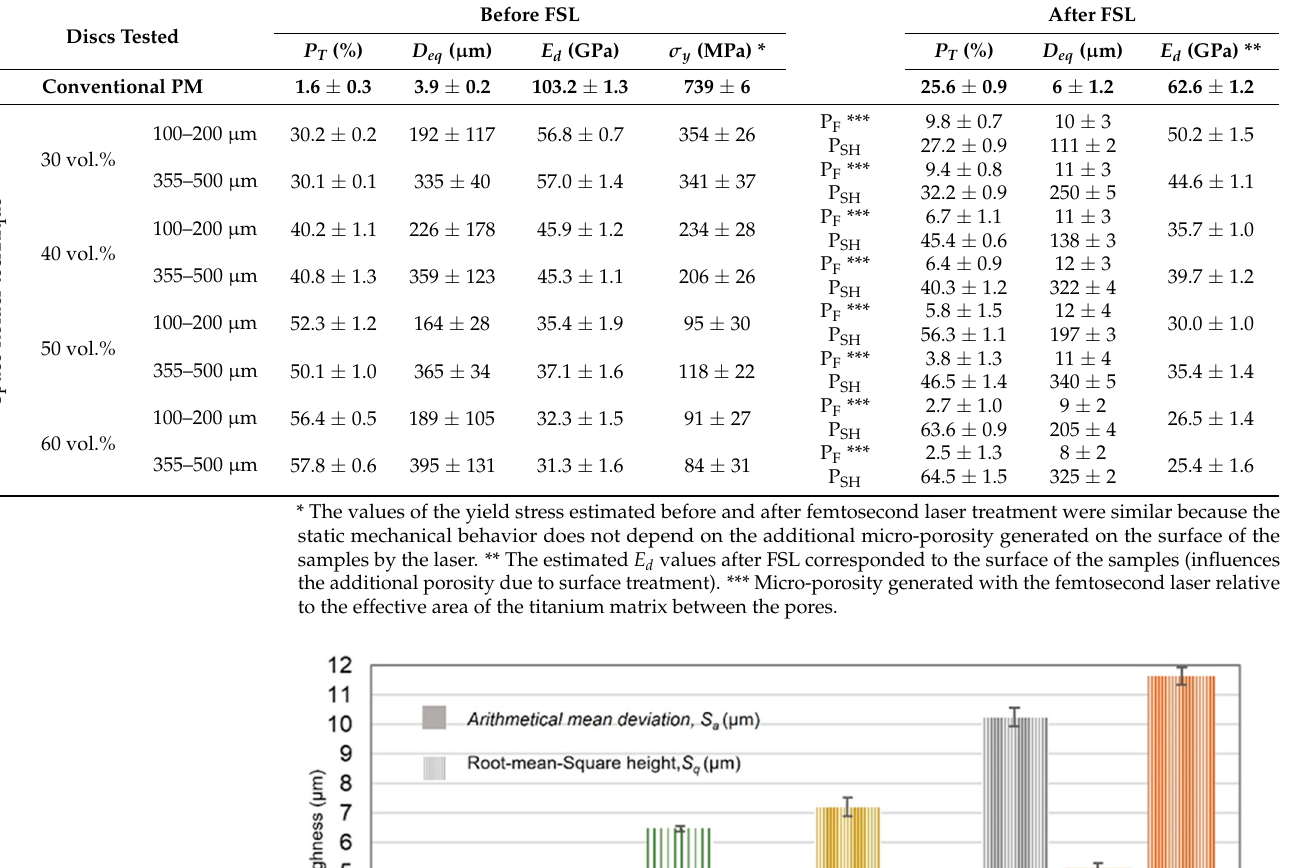
Table 1. Experimental porosity parameters and estimated macro-mechanical behavior of porous implants before and after FSL. Note: Flat surface (between macro-pores).